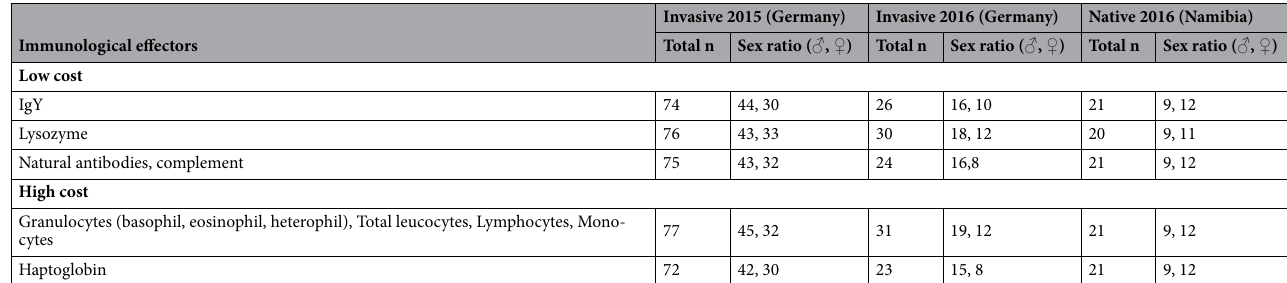
Table 1. Total sample sizes (total n ), sample sizes grouped by sex (sex ratio ( ♂ , ♀ )) and year of sampling of blood and serum samples from Namibian (native) and German (invasive) Egyptian geese ( Alopochen aegyptiacus ) for each immunological effector grouped by the costs of immunity (low costs vs. high costs according to Klasing 39 and Lee and Klasing 9